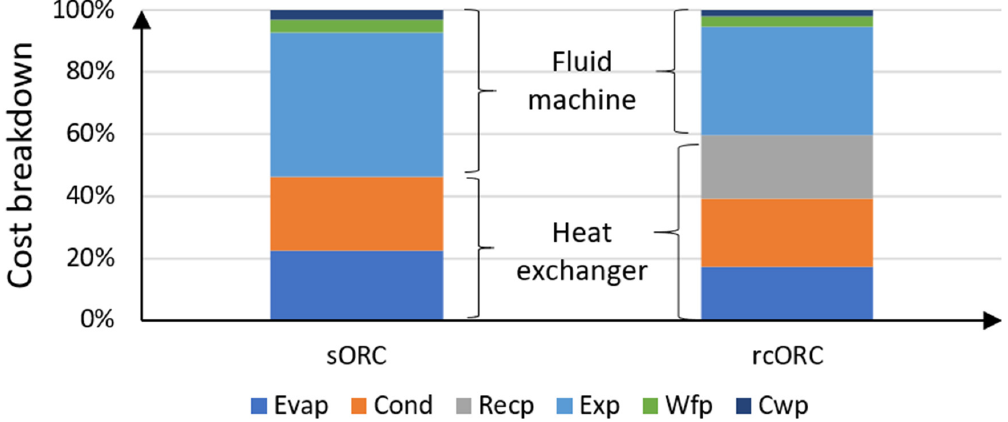
Figure 17. Cost breakdown for two different ORC configurations (100kW).